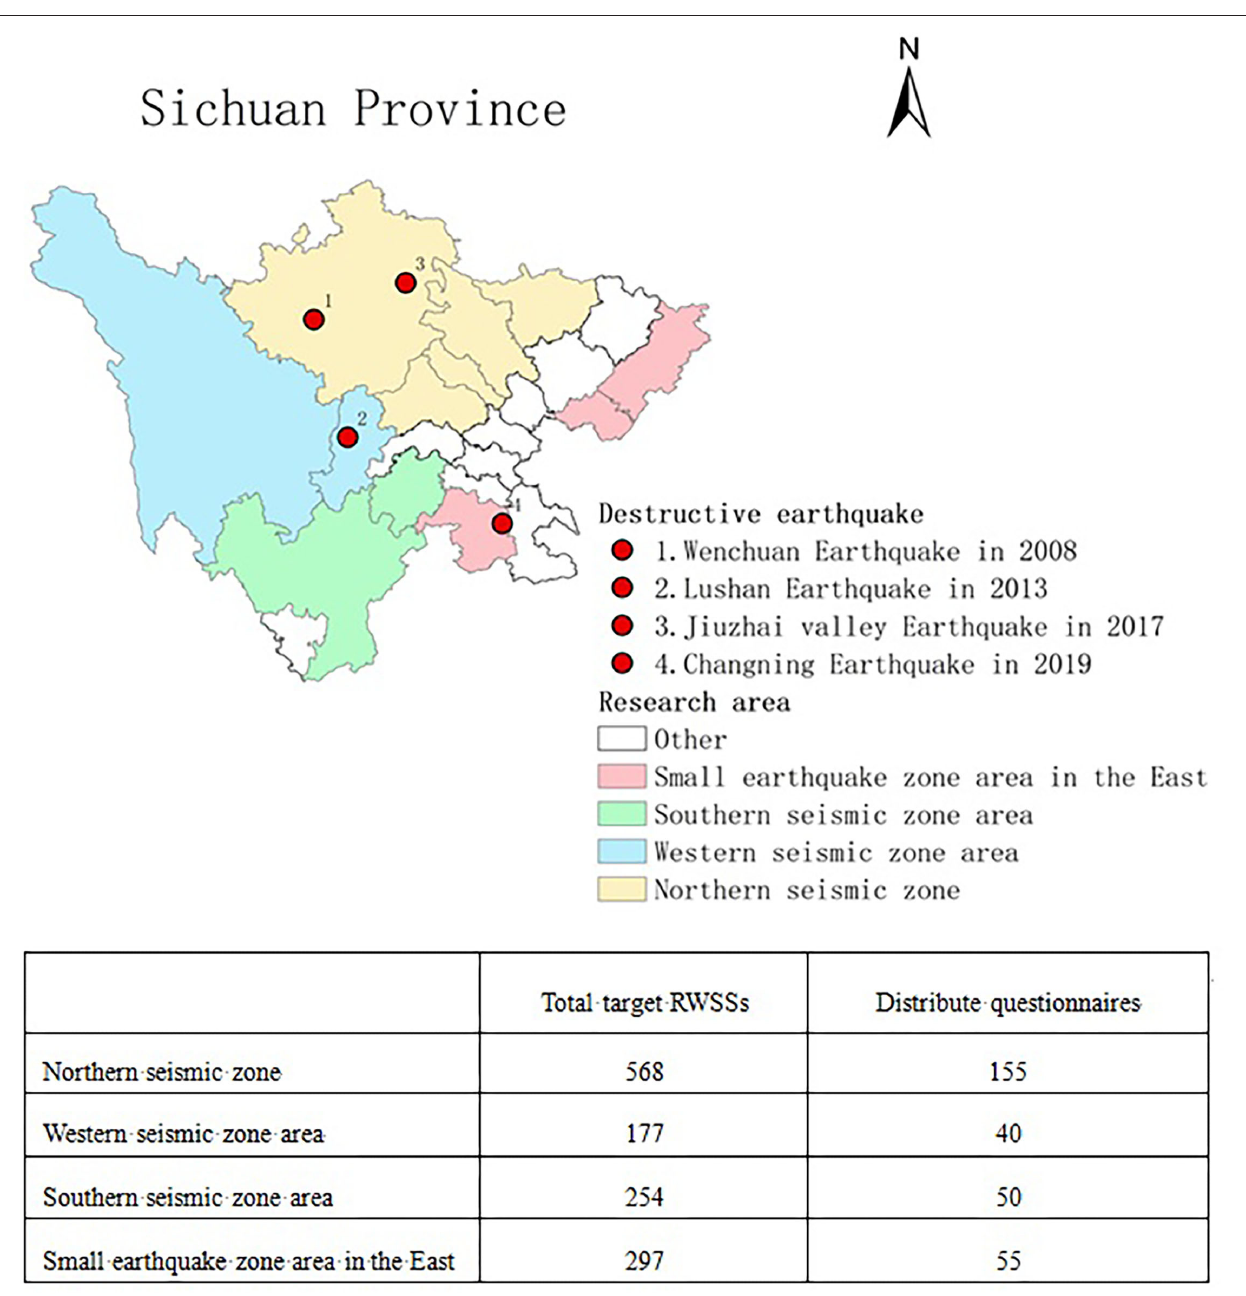
FIGURE 3 | Distribution map of survey area in Sichuan